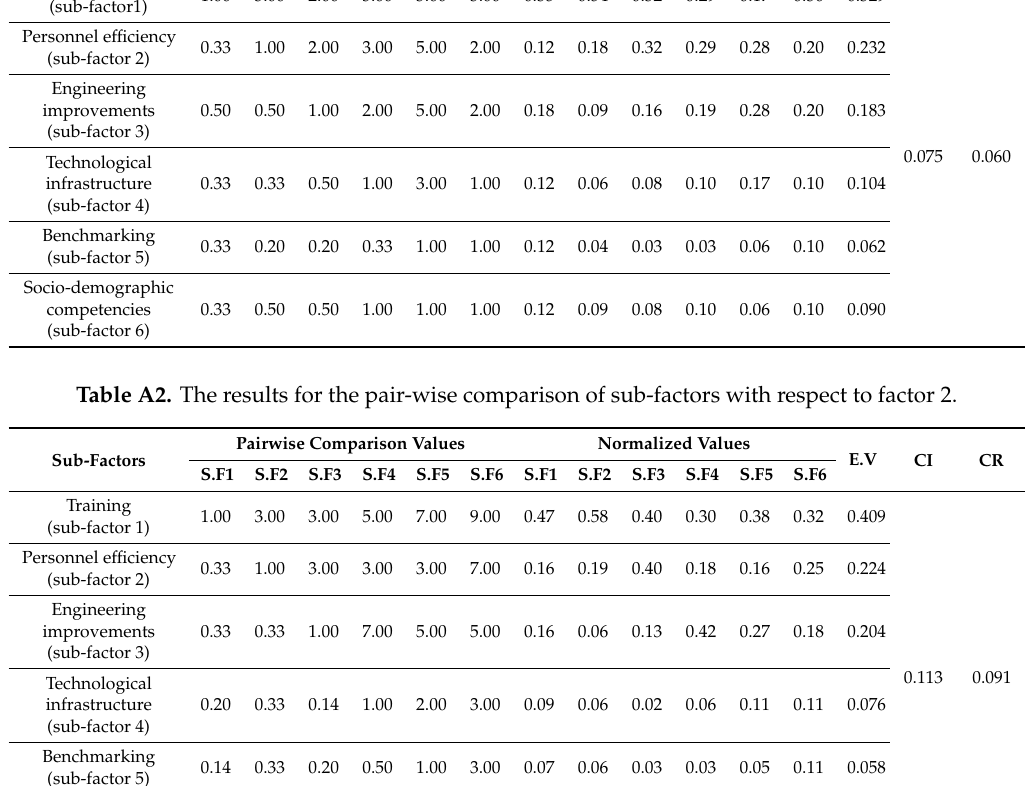
Table A1. The results for the pair-wise comparison of sub-factors with respect to factor 1. Pairwise Comparison Values Normalized Values Sub-Factors